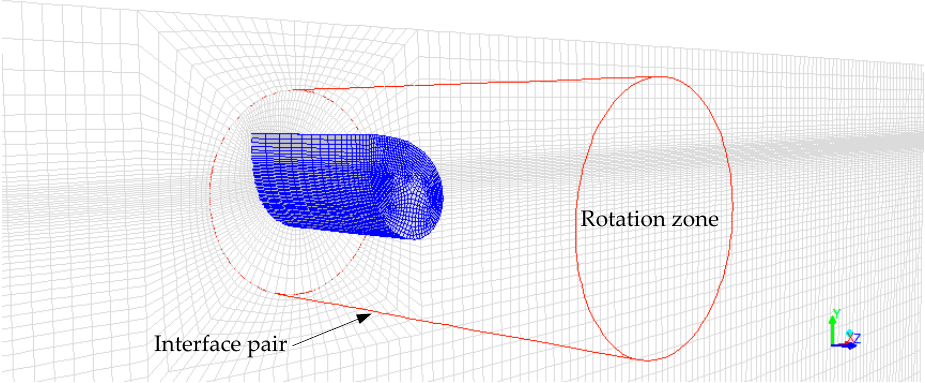
Figure 4. The mesh near the Duck.